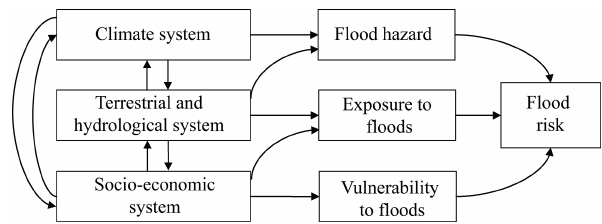
Figure 2. Conceptual sketch of components of flood risk and its drivers (after Kundzewicz et al., 2018c,